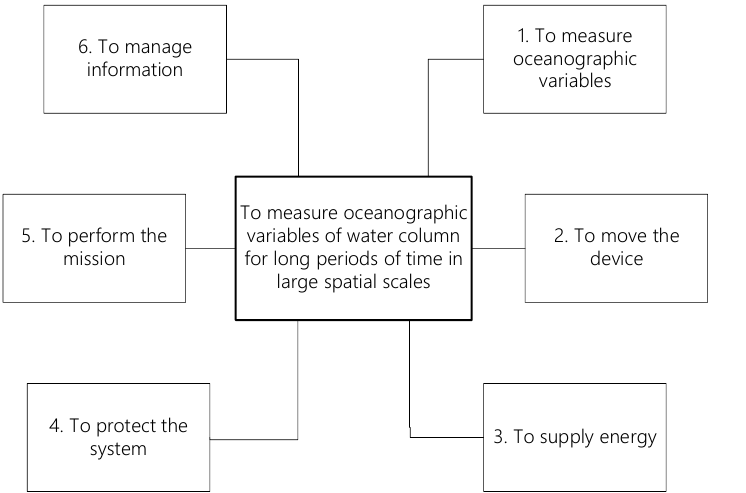
Figure 2. Main functions of the system.